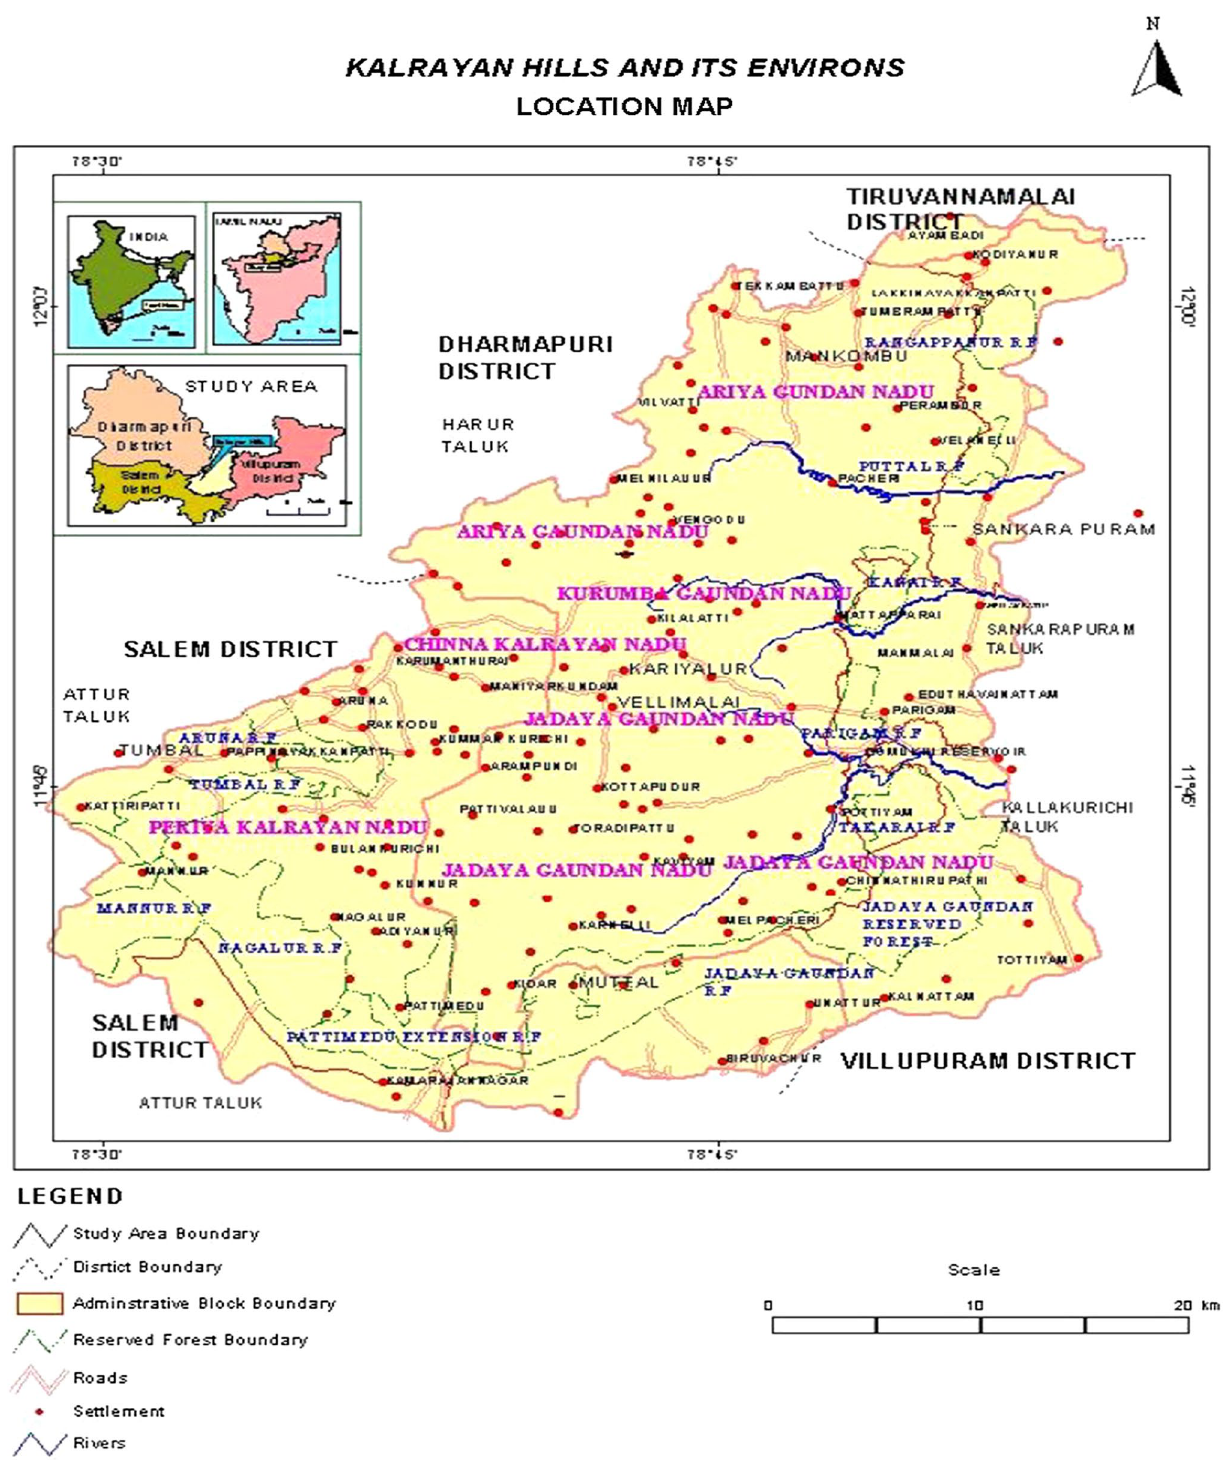
Fig. 1 Location map of the study lineaments and their points of intersection have been iden- tified, and most of them show NE–SW trending direction (Sakthivel et al. 2003). A prominent shear zone trending